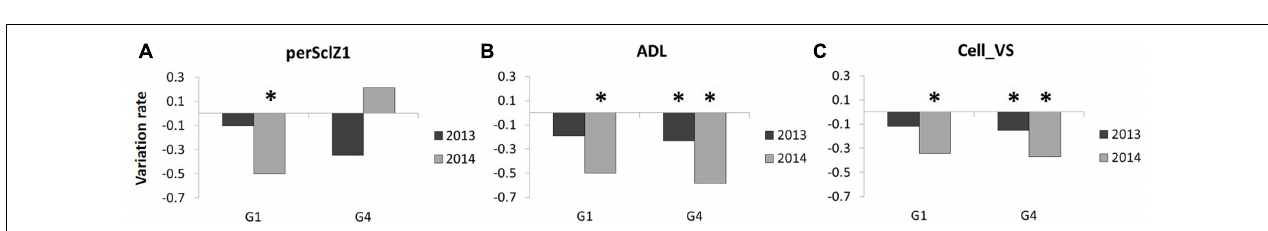
FIGURE 5 | Dynamics of perSclZ1 (A) , ADL (B) , Cell_VS (C) , Hemi_VS (D) (perSclZ1: percentage of sclerenchyma tissue (red stained) in % of Z1 area, ADL: Acid Detergent Lignin in %DW, Cell_VS: cellulose content in %DW, Hemi_VS: hemicellulose content in %DW) as a function of sorghum internode age expressed in thermal time cumulated since their growth onset; average for 2 genotypes (G1: Biomass140 and G4: RE1xAR4) for each year (2013 and 2014), for the well-watered treatment only. Each point is the average (with standard error bars) of the three blocks. All internodes sampled at the end of the stress period and the final harvest were used (2013: 2nd and 4th ranks below the last ligulated leaf and 2014: last ligulated leaf rank and 2nd, 4th, and 6th ranks below).